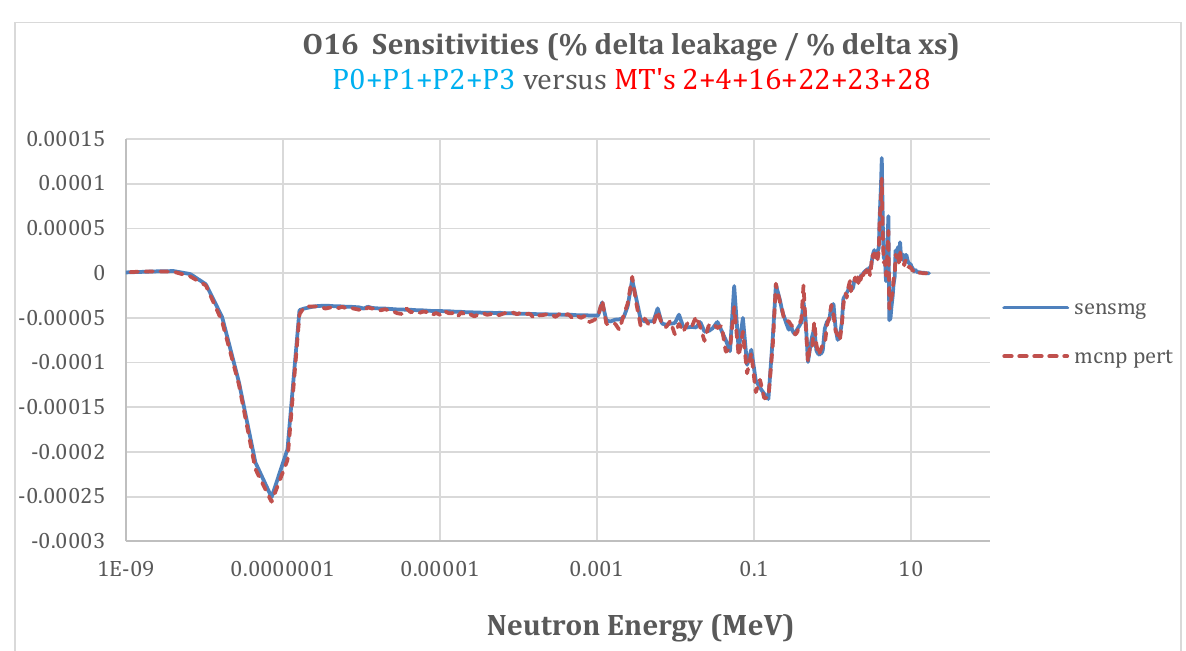
Figure 3. Equivalence of Sensitivities Calculated by MCNP and SENSMG